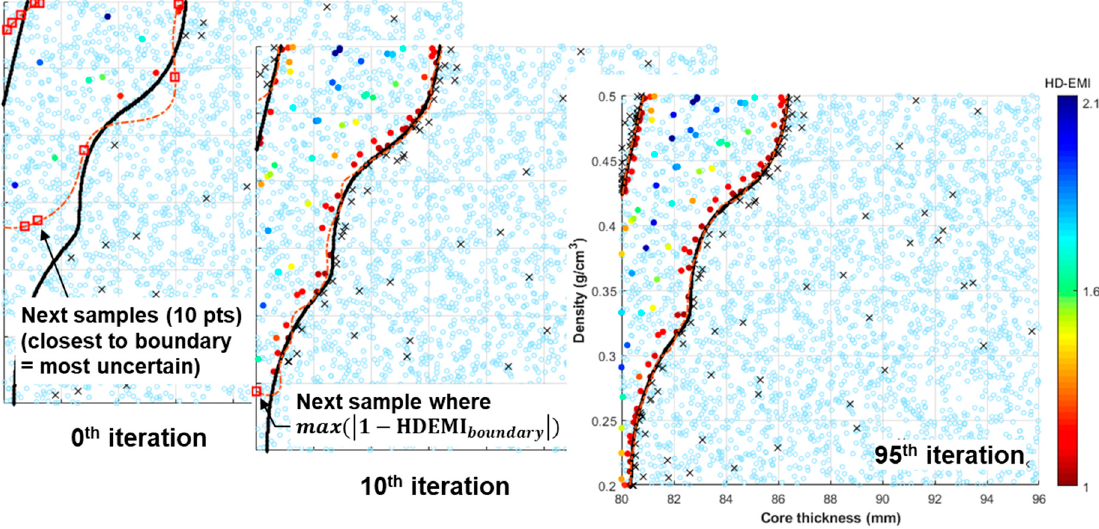
Figure 9. Double-loop active learning iterations at property level.